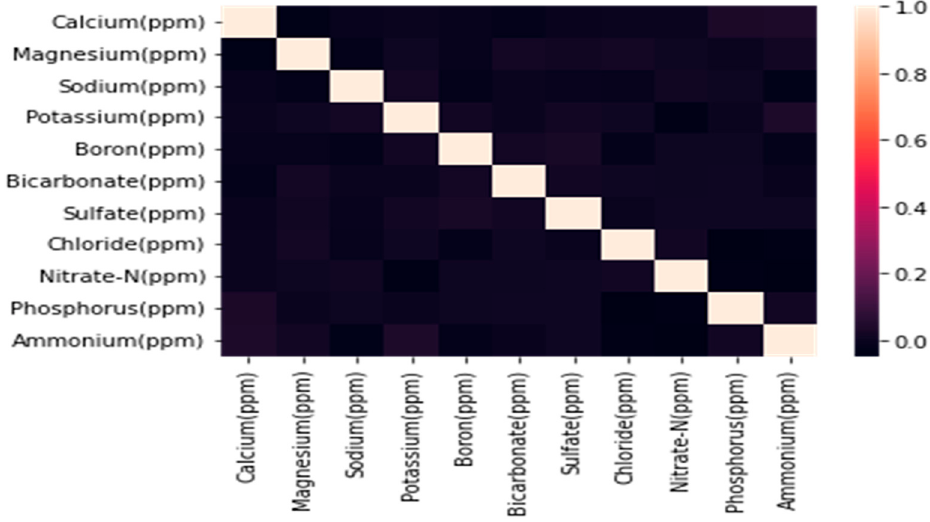
Figure 4. Pairwise correlation matrix among all the nutrient predictors in the dataset.